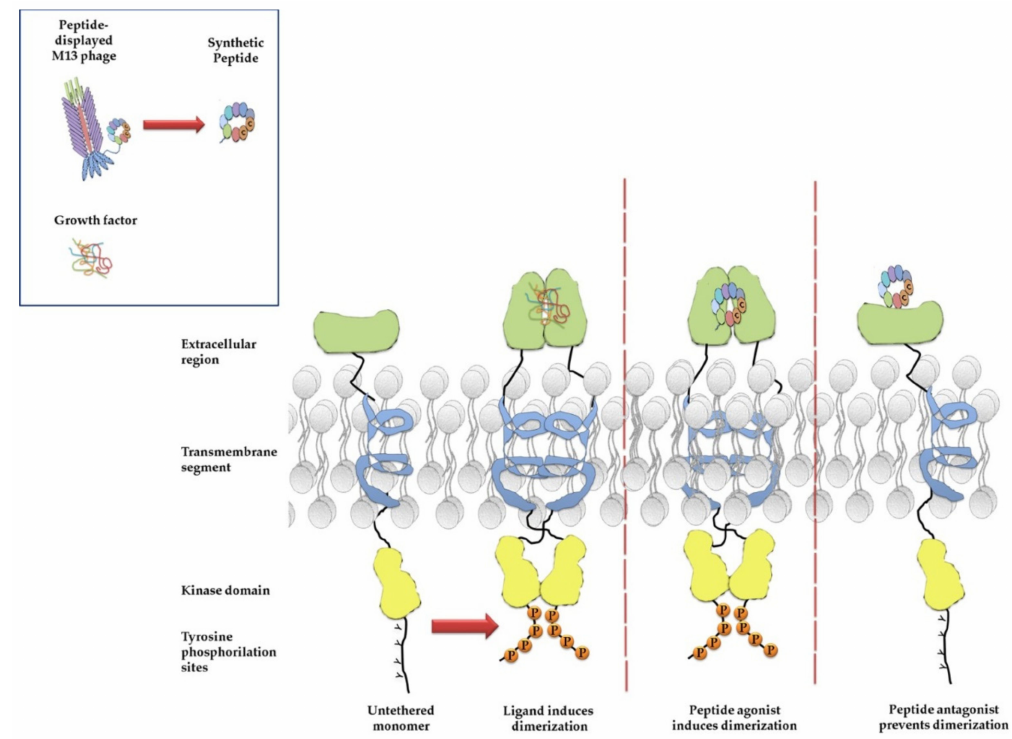
Figure 3. Activation mechanism of a tyrosine kinase receptor. In absence of the ligand, the tyrosine kinase receptor is inactive. The binding of the ligand induces a conformational change of the receptor, causing dimerization and cross-interaction of the dimerization loop within the ectodomain with the ligand. The ligand can be a natural ligand, such as a cytokine or growth factor, or a peptide selected by phage display acting as mimotope of the ligand. The active receptor tyrosine kinase auto-phosphorylates specific tyrosines within the intracellular domain, acting as docking sites for molecules of downstream signaling. A peptide ligand can act as agonist or antagonist of the receptor